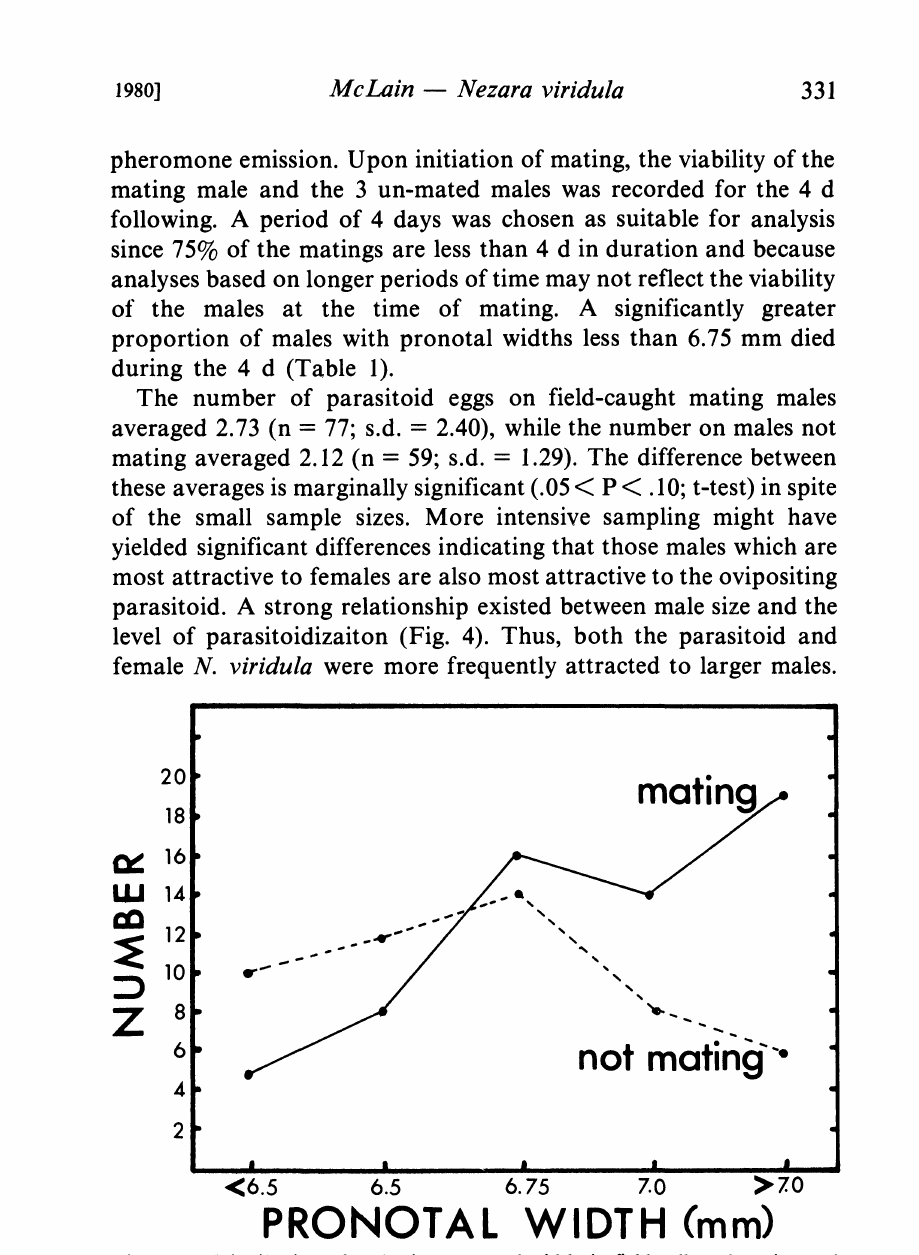
Figure 3. Distribution of male size, pronotal width, in field collected mating and non-mating males. The proportion of mating males with pronotal widths greater than the modal width of 6.75 mm was significantly greater than the proportion in non-mating males (P<.05, t=2.5;